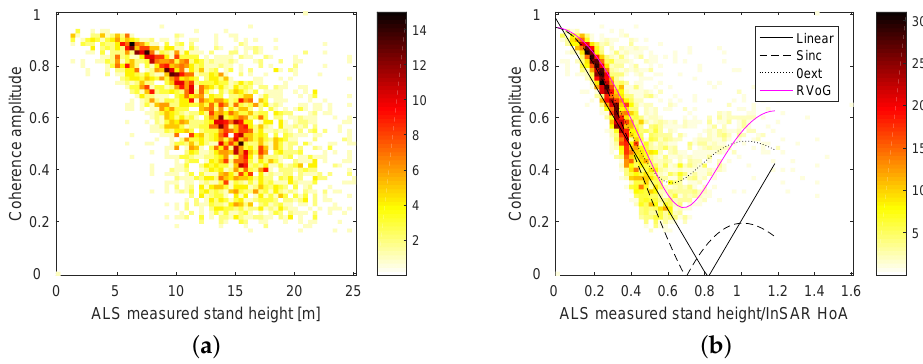
Figure 4. TanDEM-X coherence against Airborne LiDAR Scanned (ALS) forest height for the entire dataset (19 TDX image pairs and 3787 forest stands). The colors represent how many coherence-stand height pairs fall into the value range. On the left ( a ), the coherence magnitude is compared to forest stand height, and on the right ( b ), the coherence magnitude is compered to ALS forest height divided by HoA (9)